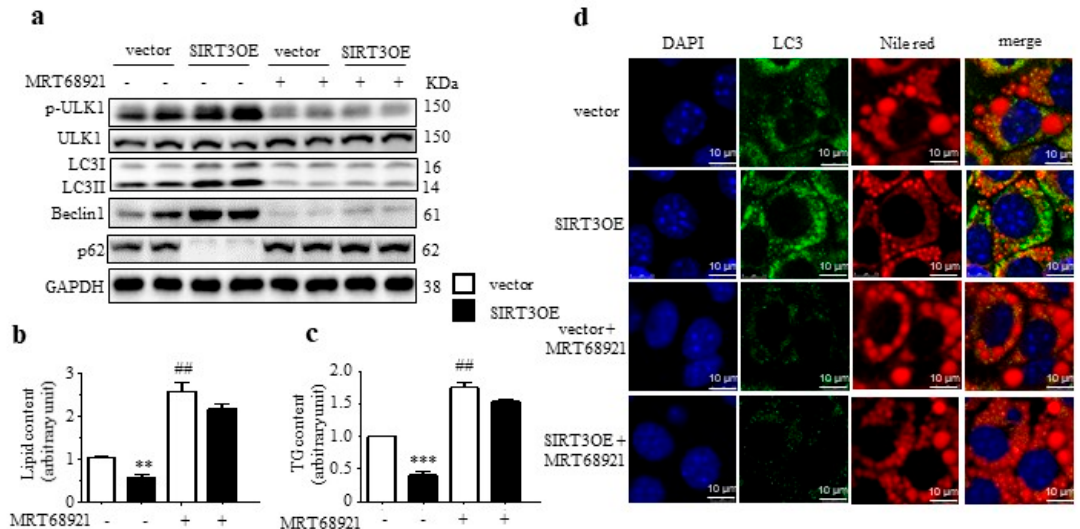
Figure 5. SIRT3 activates macroautophagy in adipocytes through the AMPK-ULK1 / 2 pathway. ( a ) LC3, Beclin1, p62, phosphorylated ULK1 and total ULK protein levels in vector and SIRT3OE adipocytes treated with or without MRT68921. GAPDH was used as a loading control. The lipid content ( b ) and the cellular TG content ( c ) in vector and SIRT3OE adipocytes treated with or without MRT68921. ( d ) Immunofluorescence of LC3 (green) and fluorescence of Nile Red (red) in vector and SIRT3OE adipocytes treated with or without MRT68921. Nuclei were stained with DAPI (blue). Scale bar = 10 µ m. Data are shown as mean ± S.D., n = 6, ** p < 0.01, and *** p < 0.001 vector versus SIRT3OE cells. ## p < 0.01 vehicle control versus MRT68921 treated cells.